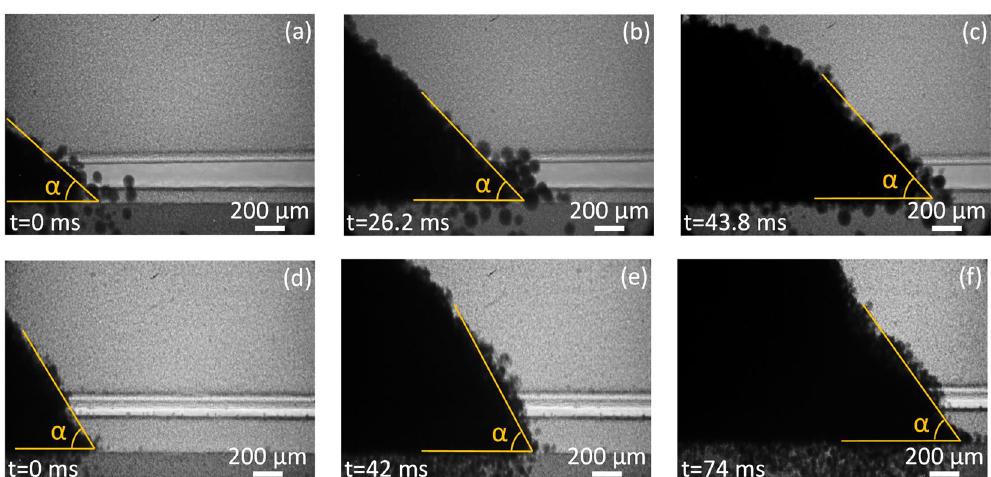
Figure 2. Dynamic x-ray images showing the evolution of dynamic repose angle “ α ” during the spreading of 316 L stainless steel powders with two different average powder diameters. ( a – c ) 316 L stainless steel powder with an average diameter of 67 µ m. ( d – f ) 316 L stainless steel powder with an average diameter of 23 µ m. The two powders were spread with a constant spreading speed of 11.5 mm/s from left to right. A rigid aluminum blade with a flat front (perpendicular to the building platform), was used as the wiper. The powder was spread under an ambient pressure of 1 atm within a stainless steel chamber. The dynamic repose angle “ α ” of the powder is indicated by the yellow line on each